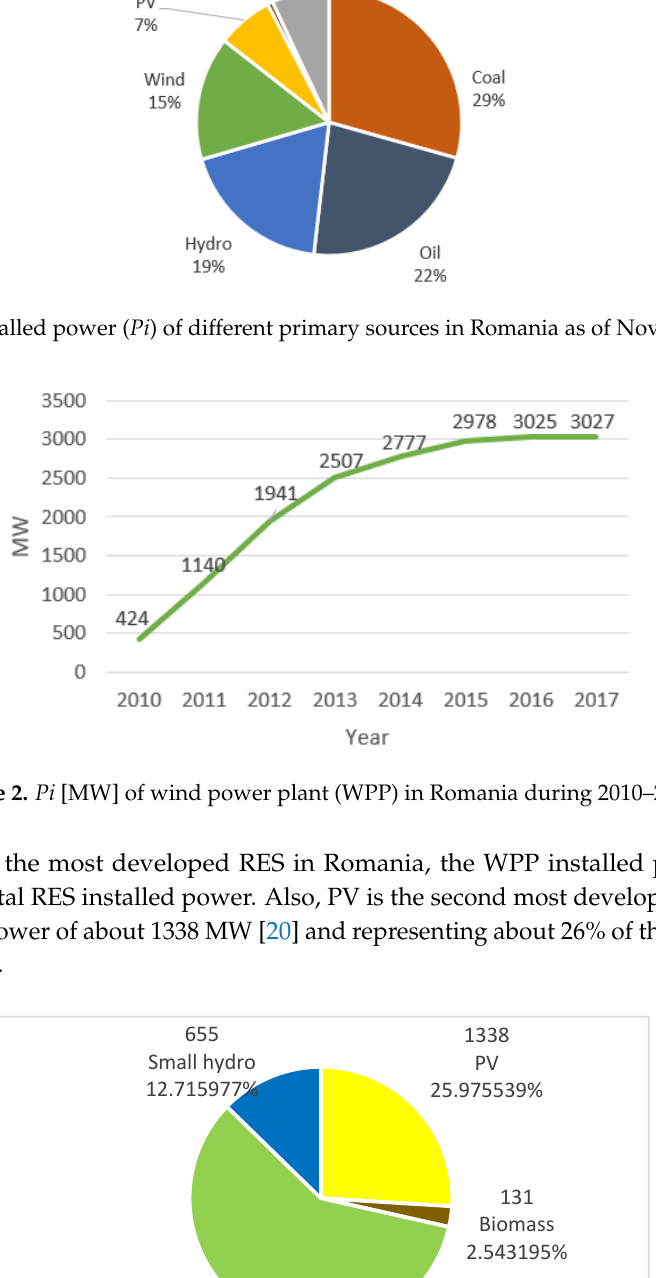
Figure 3. Pi [MW] of renewable energy sources (RES) in Romania as of November 2017.